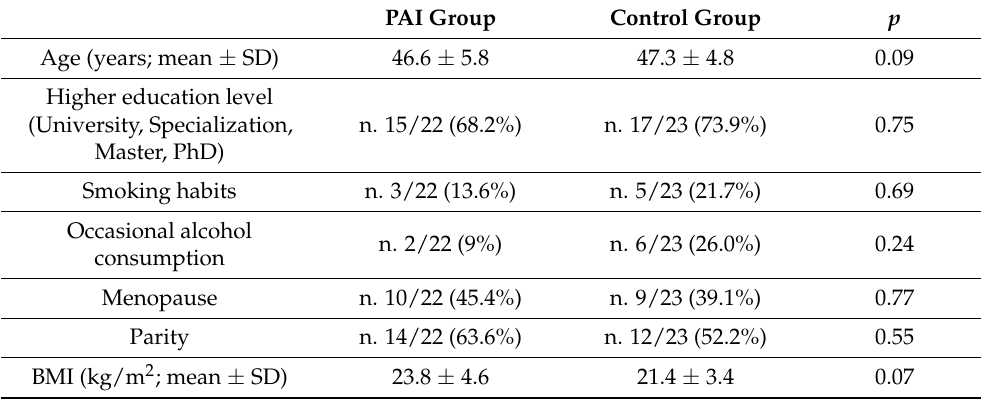
Table 1. Demographic features of primary adrenal insufficiency (PAI) group and control group.